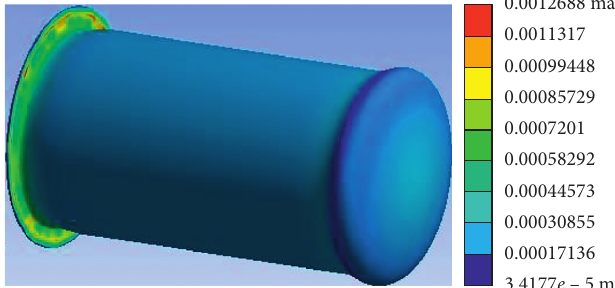
Figure 26: Equivalent strain cloud diagram of the coupled flame